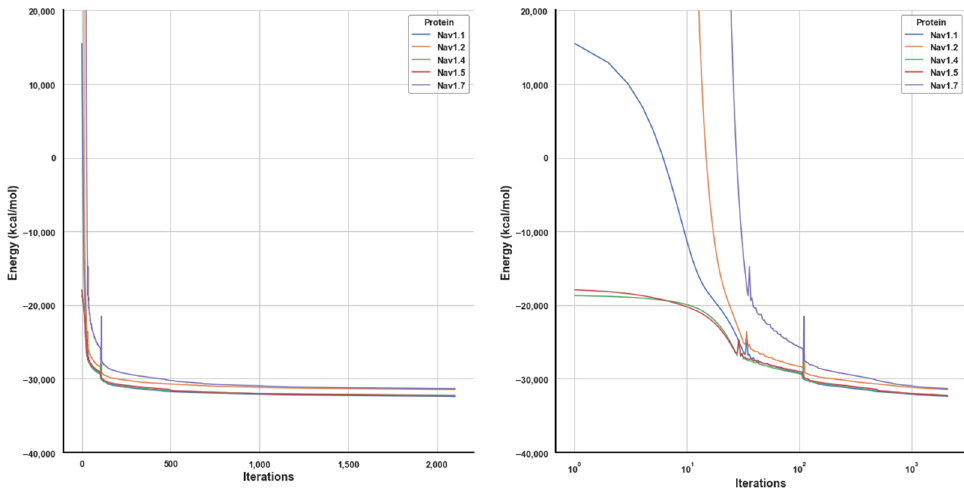
Figure 8. Minimization energy. Left: linear x axis. Right: logarithmic x axis.